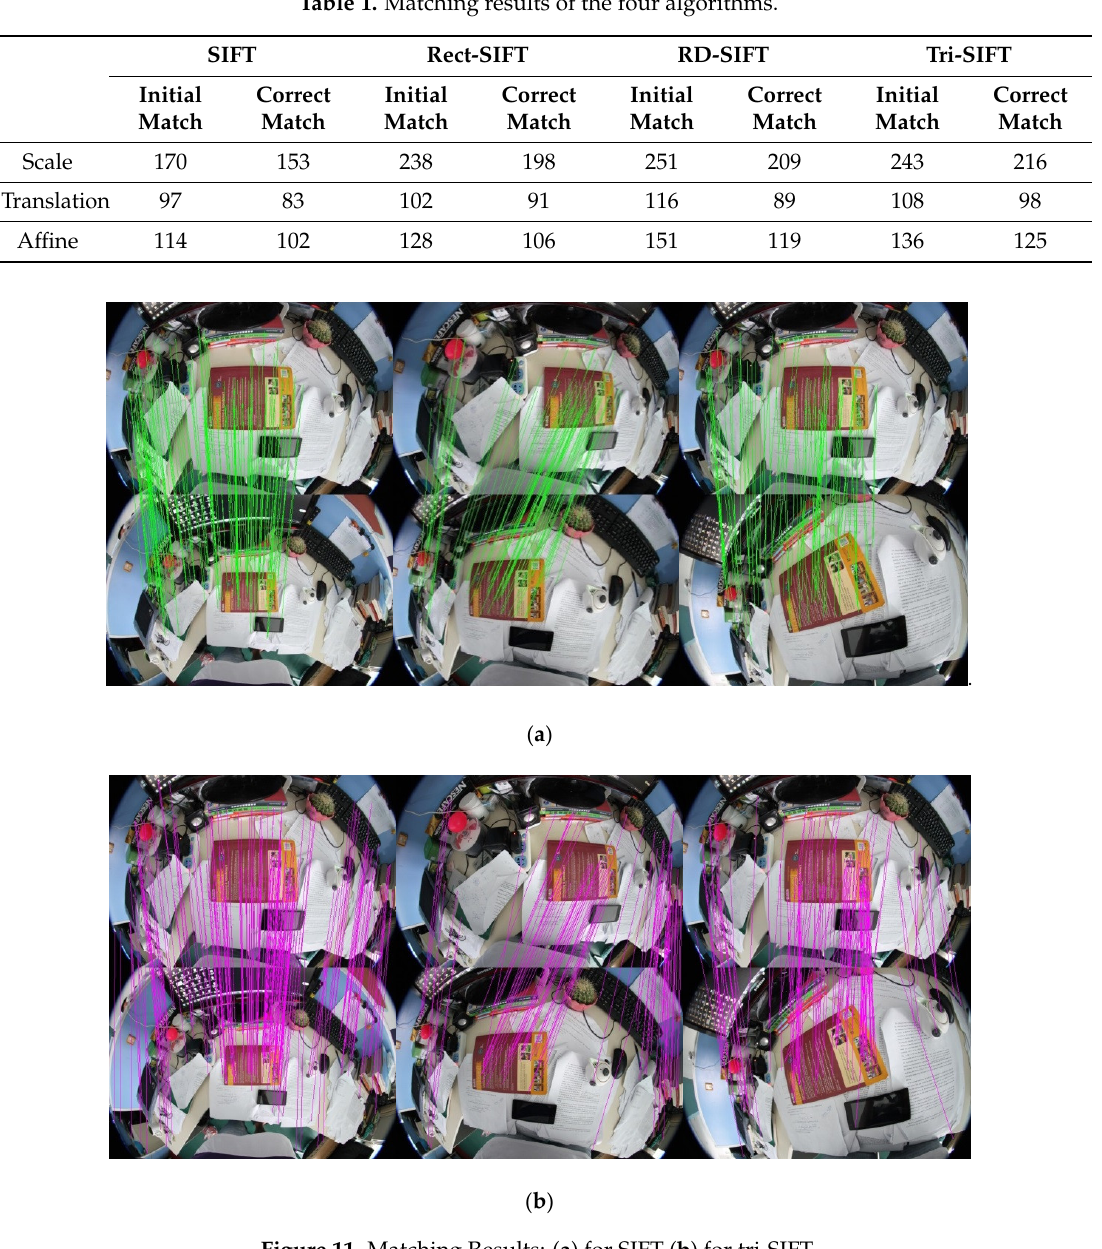
Figure 11. Matching Results: ( a ) for SIFT ( b ) for tri-SIFT.